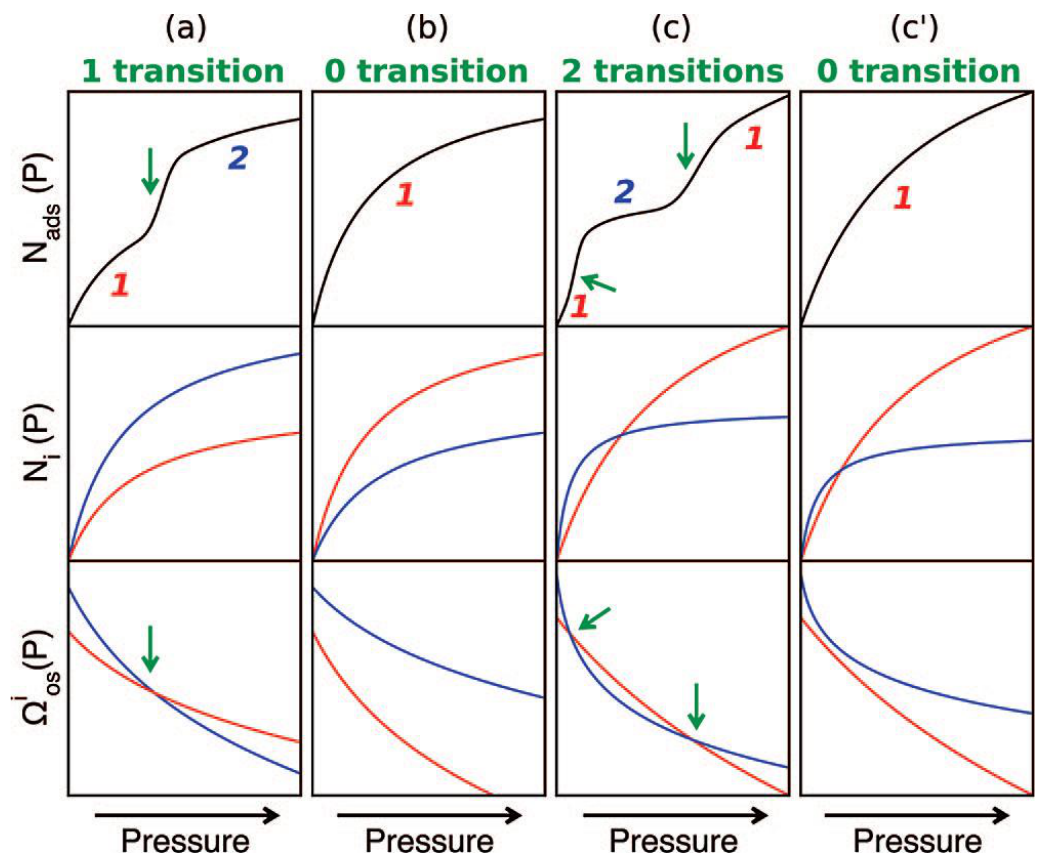
Figure 19. The four potential scenarios of adsorbents exhibiting the structural transition between Phases 1 (red) and 2 (blue), using osmotic potential ensemble model. ( Top ) the adsorption isotherms; ( Middle ) the Langmuir isotherms of each phase in respective scenario; ( Bottom ) the osmotic potential of each phase. Green arrows indicate the occurrence of structural transitions. Reprinted with permission from [125]. Copyright 2008 American Chemical